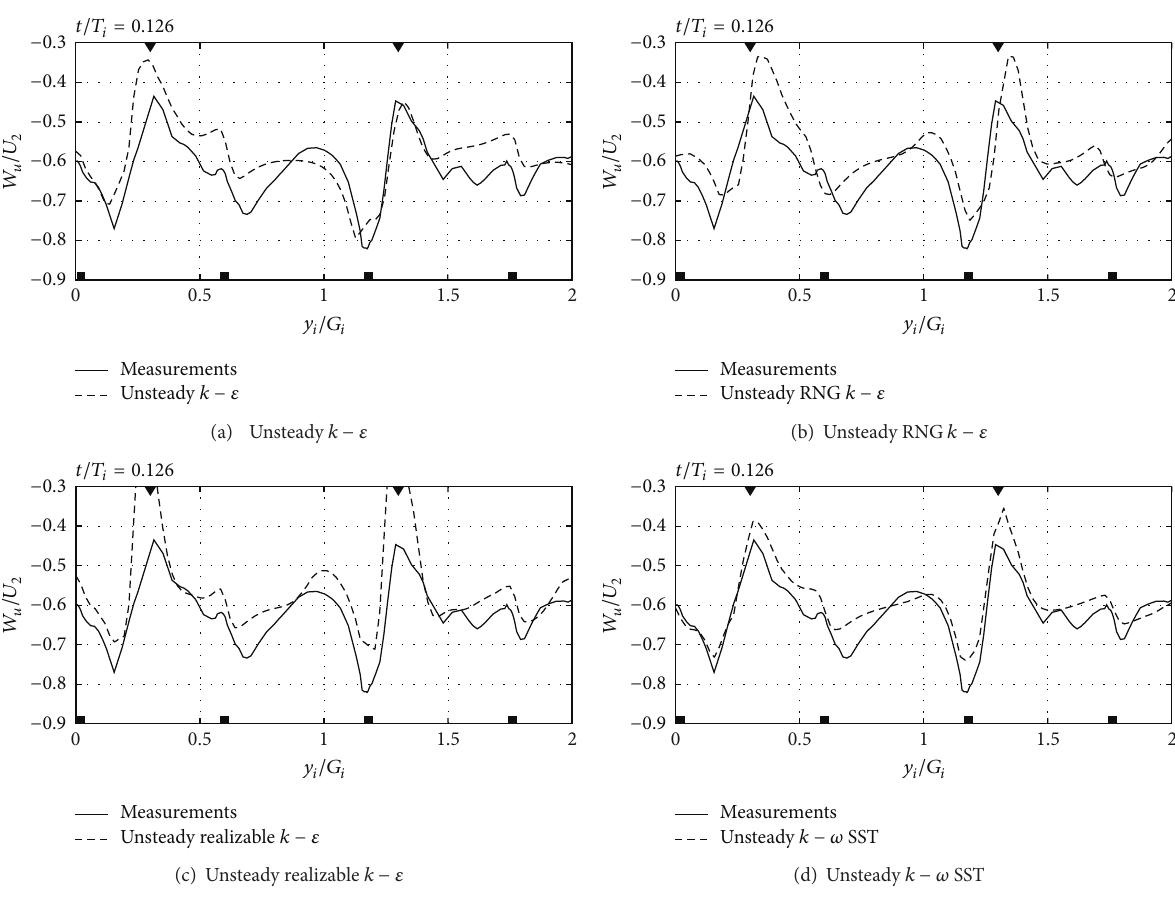
Figure 14: Tangential velocity in the radial gap ( 𝑅/𝑅 2 = 1.02 ) at